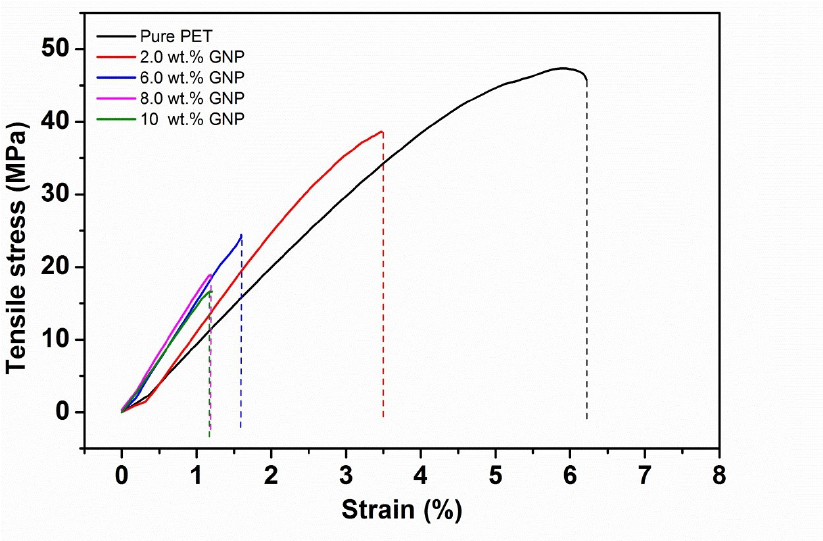
Figure 1. Typical stress-strain curves of the PET-GNP